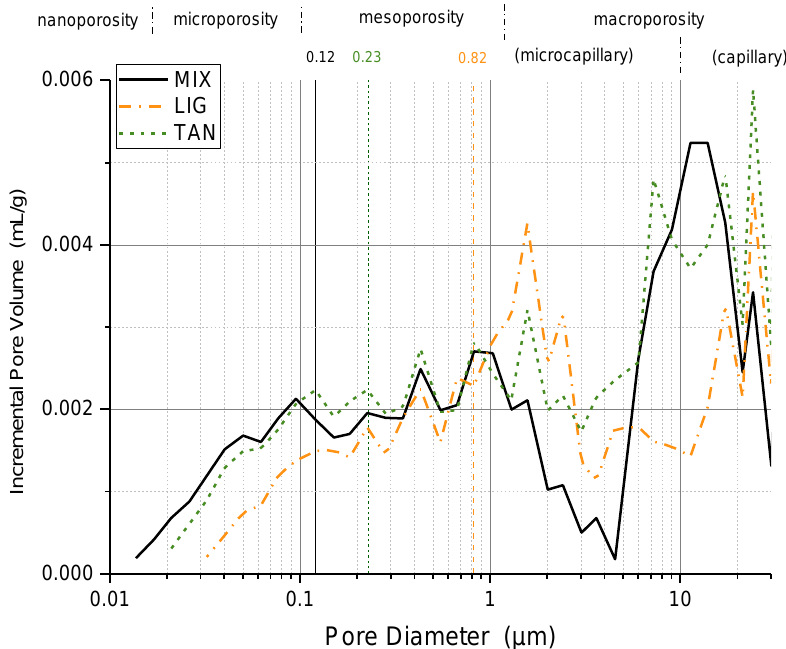
Figure 5. Incremental pore distribution from MIP analysis for the control samples and the LIG and TAN specimens.